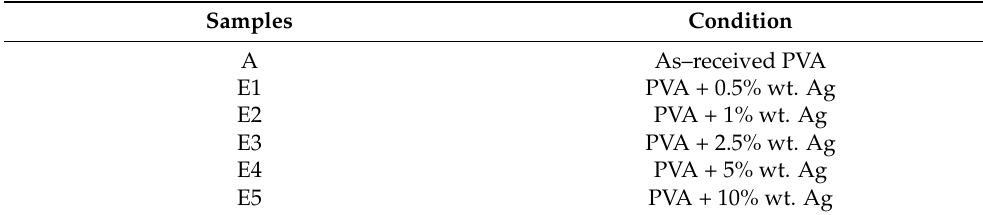
Table 3. Weight % fractions of (Ag) and Poly(vinyl alcohol) (PVA).